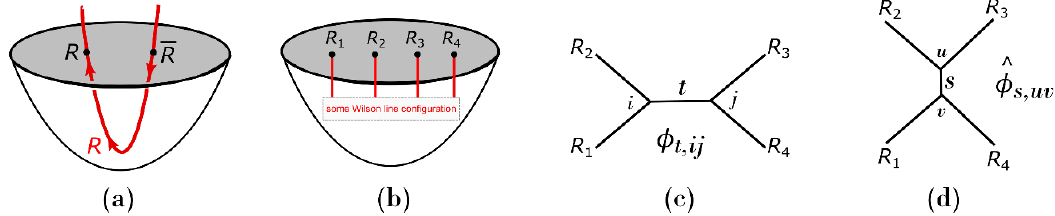
Figure 4 . A Wilson line carrying representation R intersects S 2 creating punctures marked with R or ¯ R depending on whether Wilson line is going out or going into the manifold. For four punctured boundary shown in figure (b), there are two types of basis of Hilbert space denoted as ˆ φ respectively which depend on the two ways of fusing various representations as shown in (c) s,uv (cid:30) | and